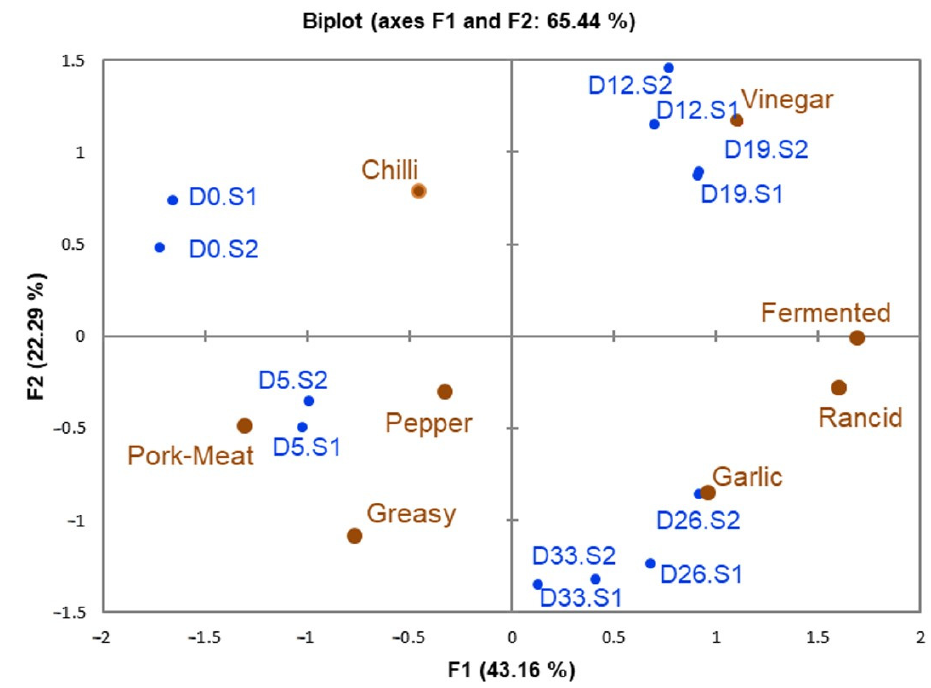
Figure 1. Biplot of Generalized Procrustes Analysis for the six days of ripening of chorizo samples (D0, D5, D12, D19, D26, and D33), and each session (S1 and S2), and the loadings of sensory de- scriptors.